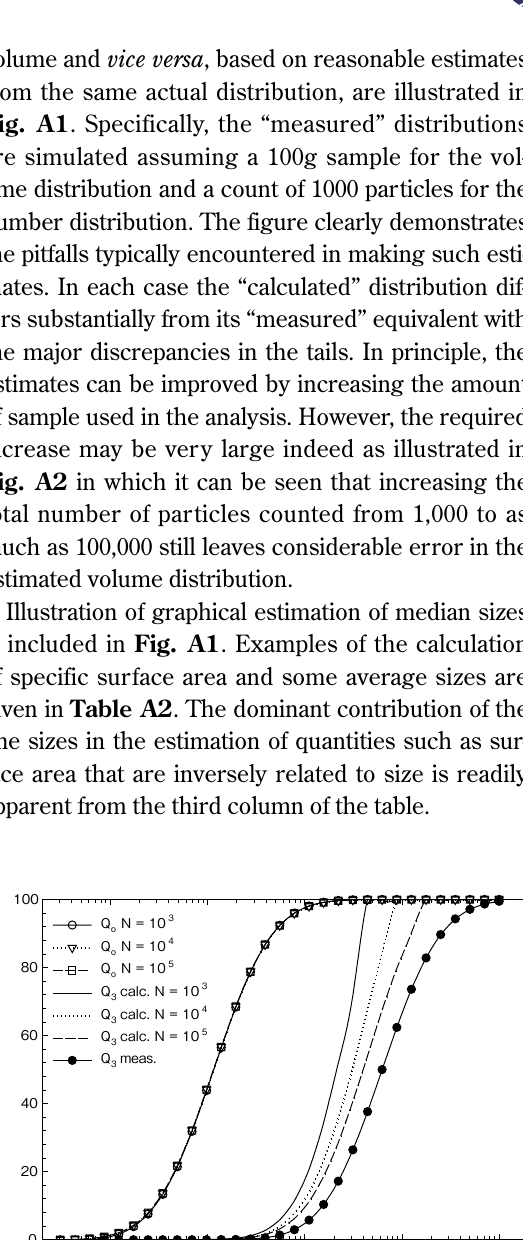
Particle Size, m Fig. A1 Examples of size distribution transformations: number to volume and volume to number.